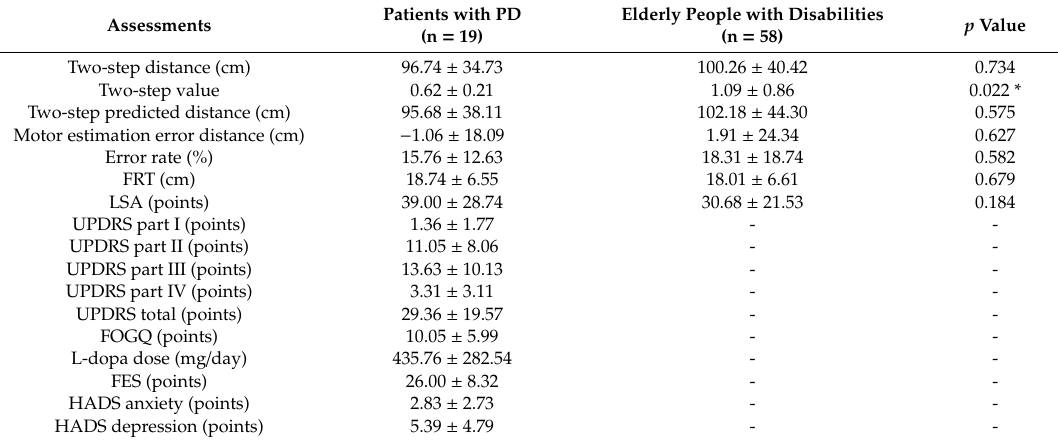
Table 2. Physical function and Parkinson’s disease-related